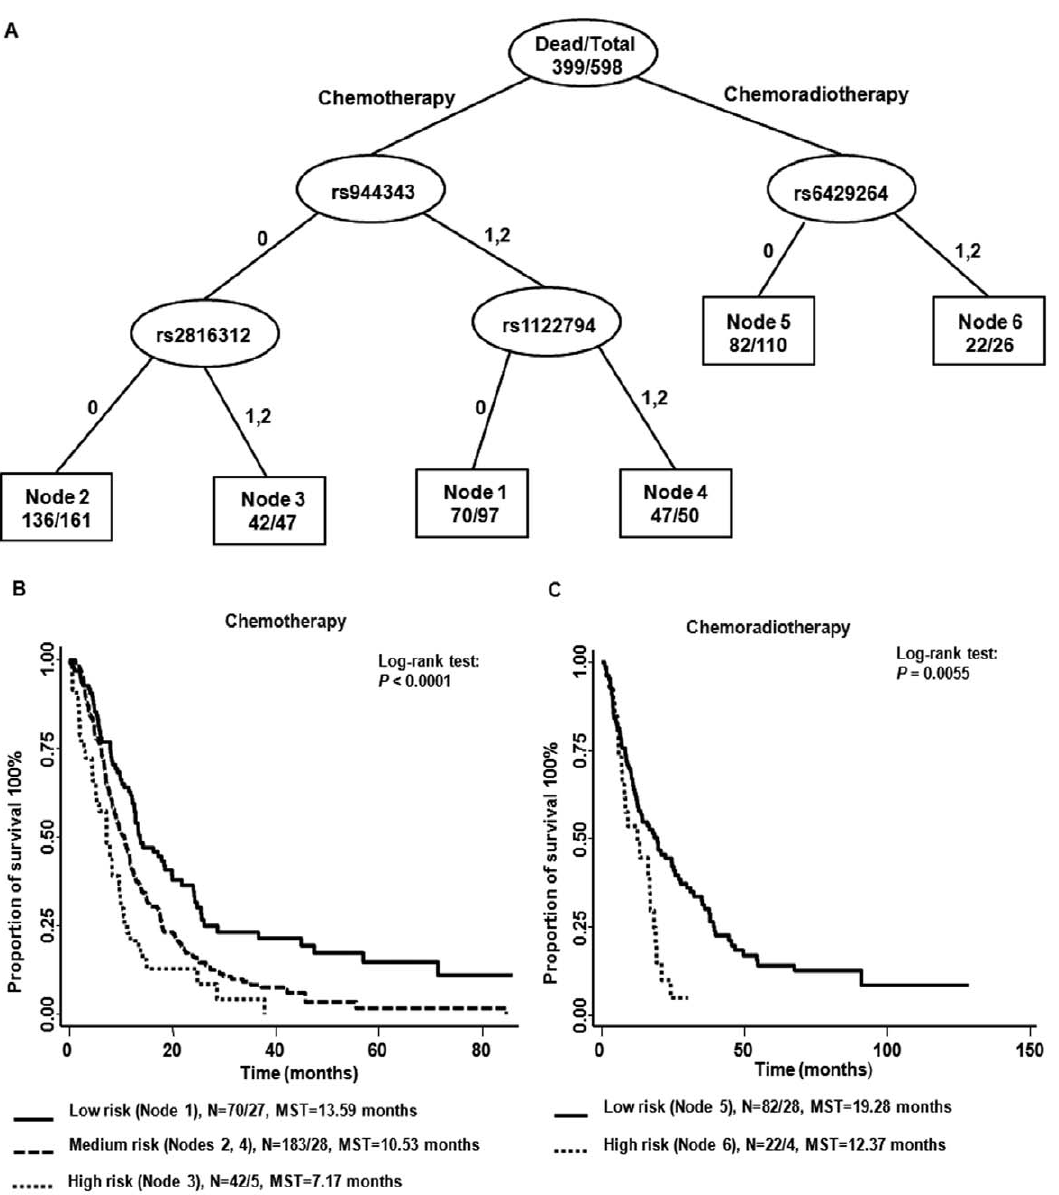
Figure 2. Survival tree analyses and Kaplan-Meier estimates of the significant RGS SNPs associated with survival . ( A ) Survival tree analyses; 0:homozygous wild type genotype; 1:heterozygous genotype; 2:homozygous variant genotype. ( B ) and ( C ) represent the survival curves of the risk group in chemotherapy group and chemoradiotherapy group; N: Number of Dead/Alive. MST: median survival time.